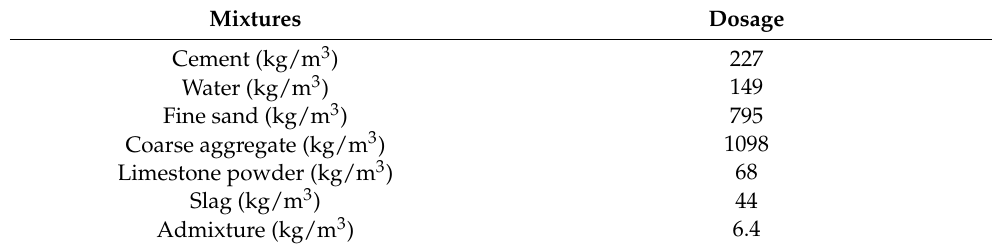
Table 1. Mix proportions of concrete.